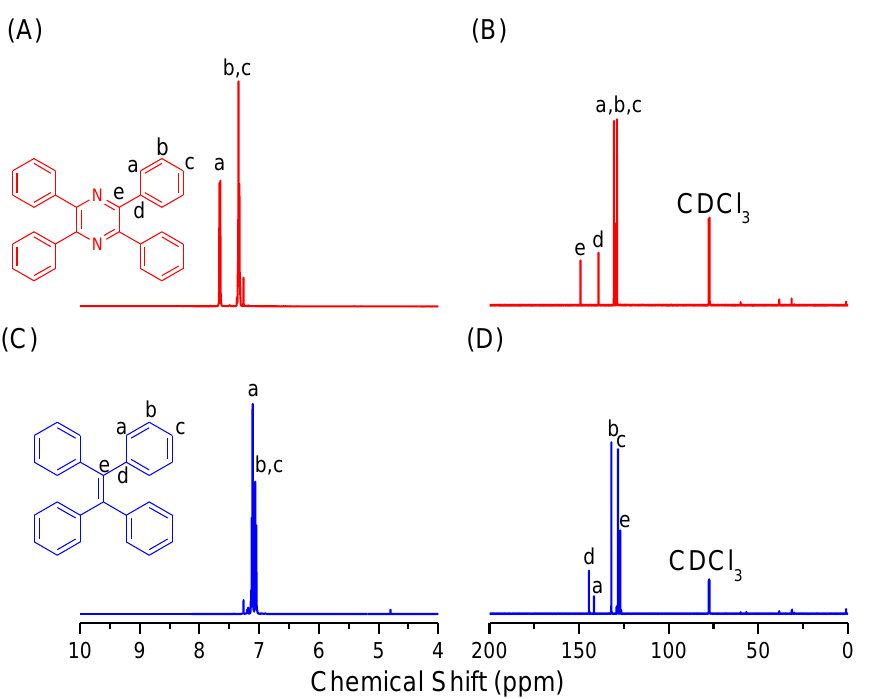
Figure 1. 1 H-NMR spectra of ( A ) POSS-TPP and ( B ) POSS-TPE, and the 13 C-NMR spectra of ( C ) POSS-TPP and ( D ) POSS-TPE.